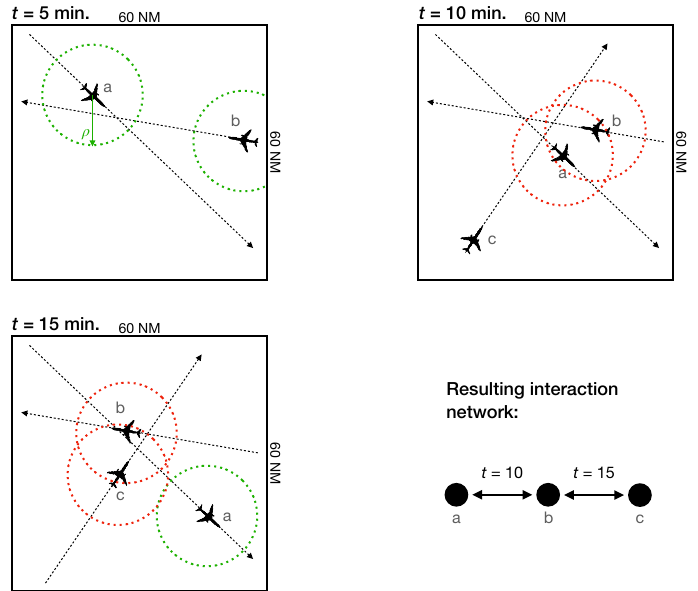
Figure 1. Example of the reconstruction of the network of interactions. The three panels represent an airspace at three different moments in time ( t = 5, 10 and 15 min), with three aircraft crossing it. An interaction between two aircraft is detected when their respective distance is smaller than a threshold ρ , depicted as dotted circles. The bottom right panel reports the resulting interaction network; note that links have a time stamp associated to them, as we assume that interactions cannot back-propagate in time (in this case, the interaction between b and c cannot propagate to a